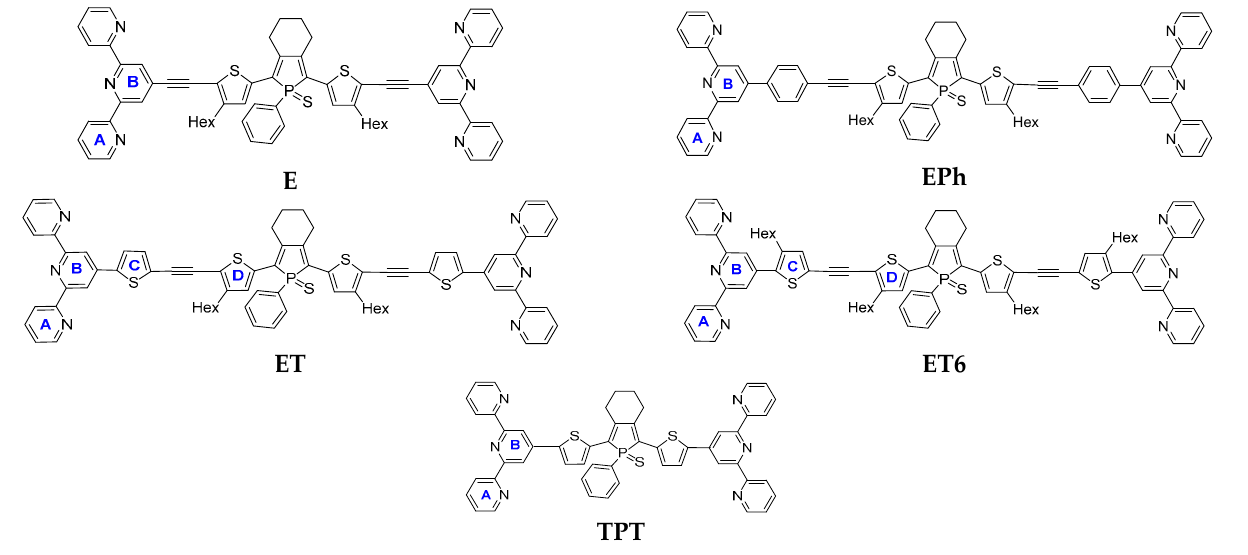
Scheme 1. Structures of the prepared new unimers (abbreviations derived from the names of linkers conneting tpy groups to the central unit) and the reference TPT unimer. (Adapted from ref. [19]).